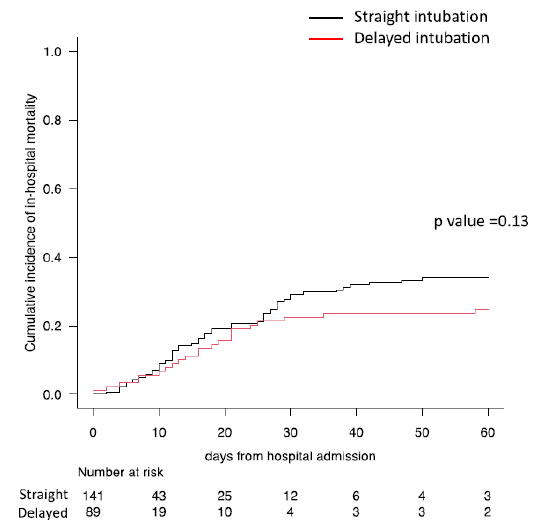
Figure 3. Difference in cumulative incidence of in-hospital mortality between straight and de- layed